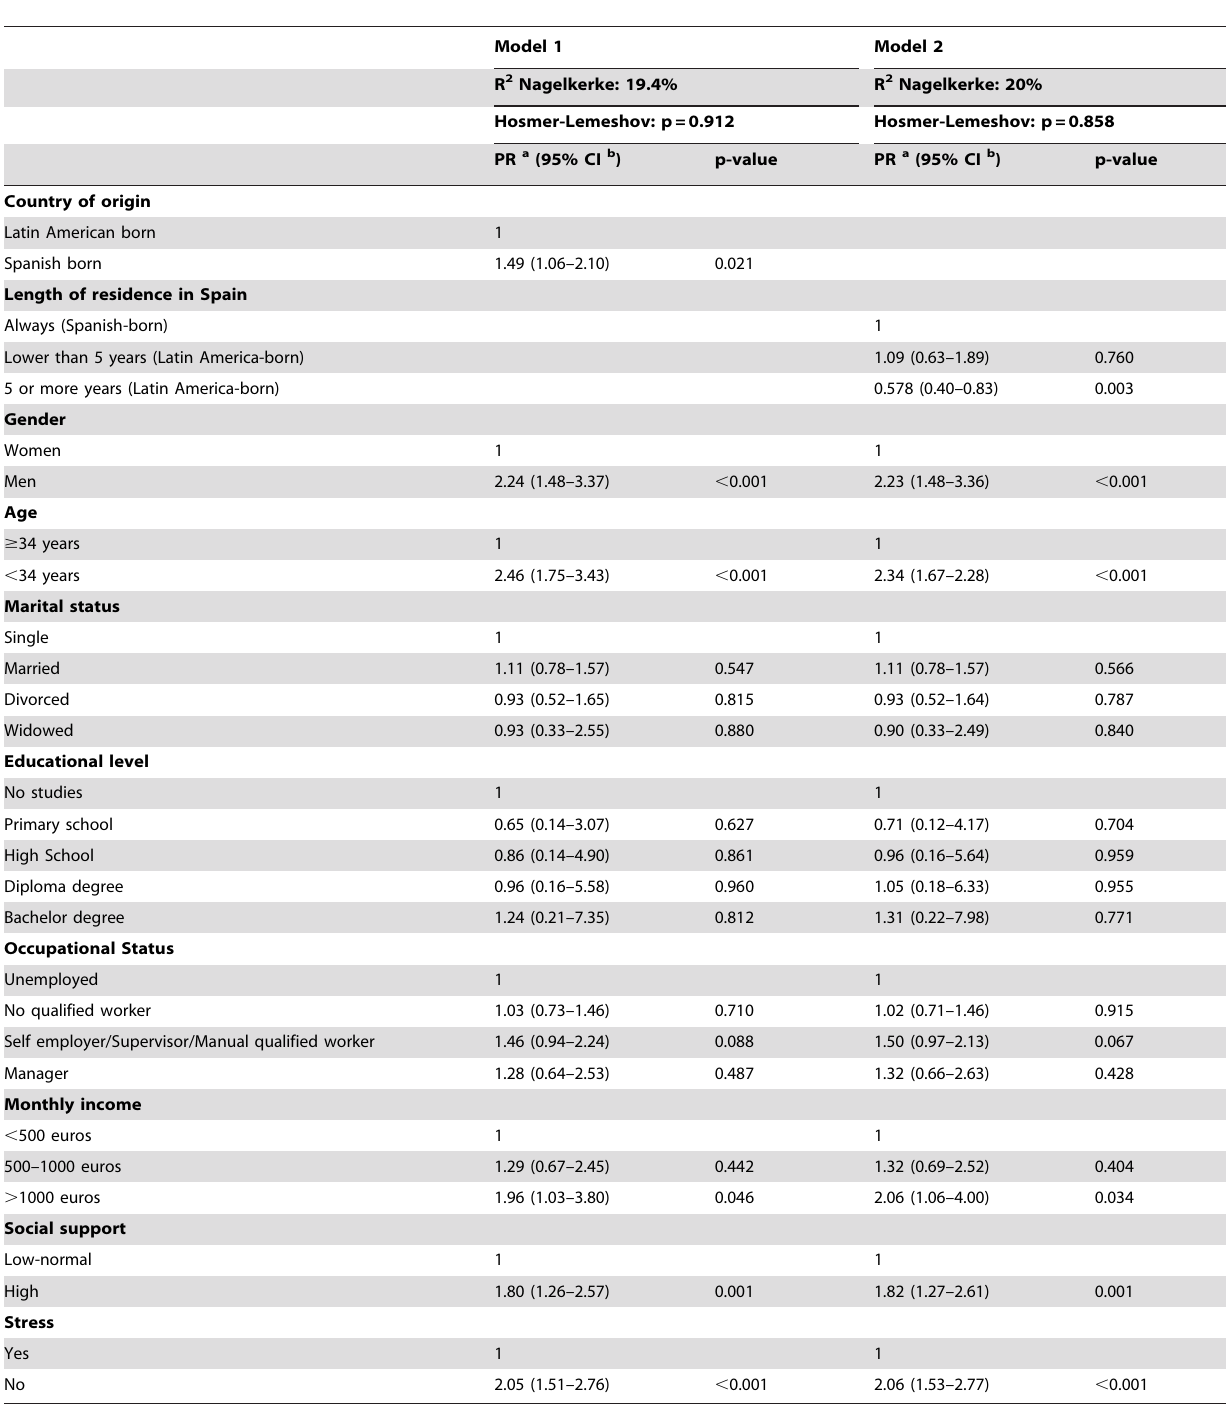
Table 4. Multivariate analysis of good/very good/excellent self-reported health